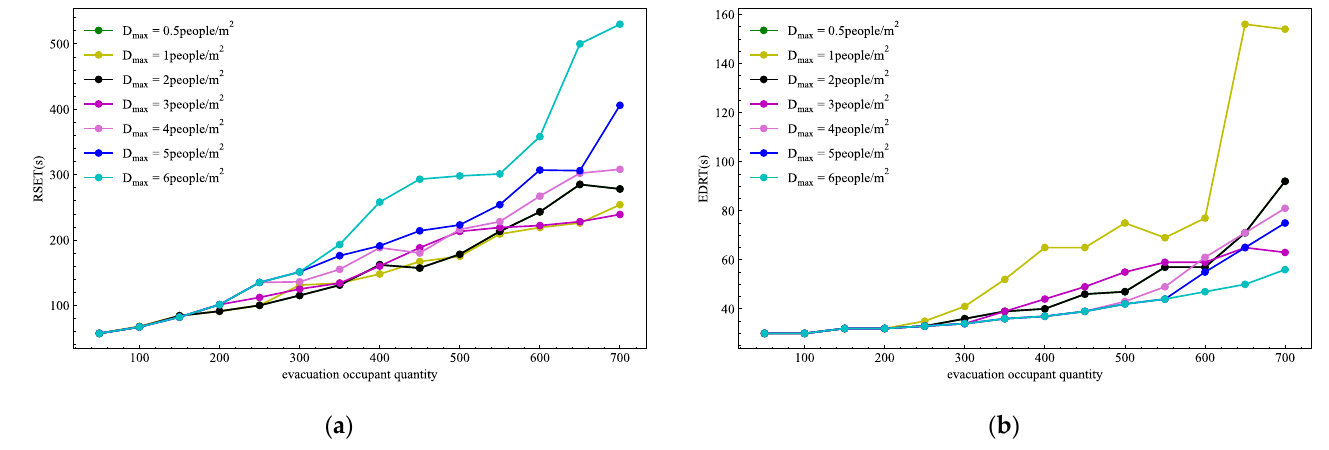
D on evacuation time is set based on the evacuees’ prior- max D on RSET; ( b ) The influence polyline of max